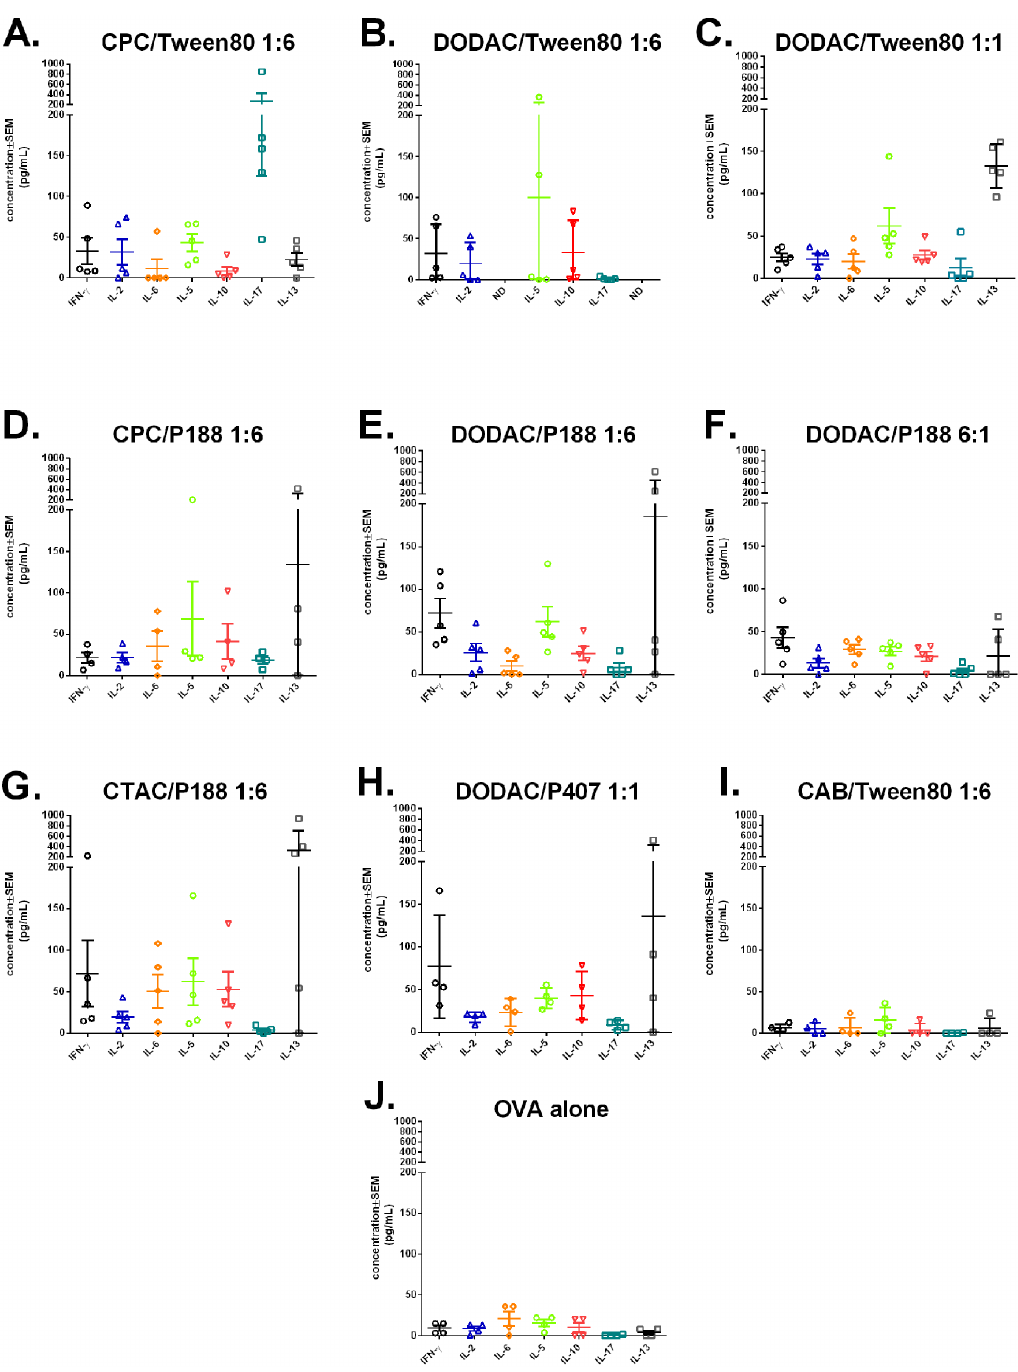
Fig 11. Cell-mediated immune response in splenocytes. Cytokine profiles of restimulated splenocytes isolated from mice after two immunizations at 10 weeks post initial immunization with (A) CPC/Tween80 1:6, (B) DODAC/Tween80 1:6, (C) DODAC/Tween80 1:1, (D) CPC/P188 1:6, (E) DODAC/P188 1:6, (F) DODAC/P188 6:1, (G) CTAC/P188 1:6, (H) DODAC/P407 1:1, (I) CAB/Tween80 1:6, or (J) OVA alone. Means are plotted ± SEM (ND = not determined).